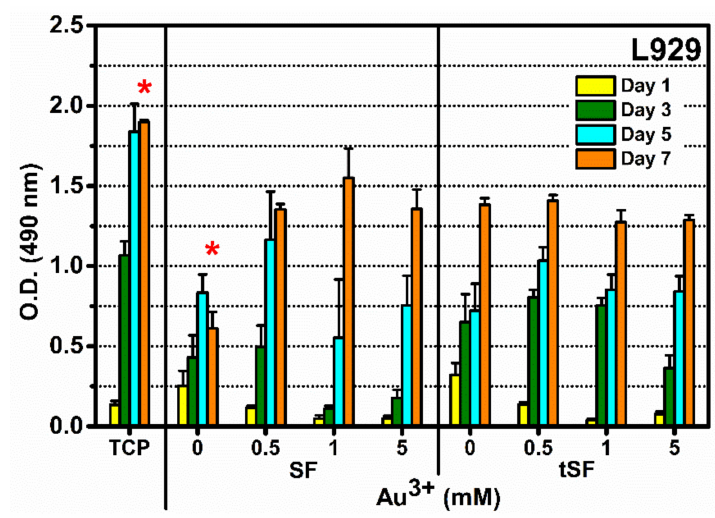
Figure 7. Cytocompatibility of SF and tSF hydrogels, and Au-SF and Au-tSF hydrogels with L929 rate fibroblasts. Cells were seeded on the hydrogels at 10,000 cells / cm 2 and cultured for 7 days. Cell metabolic activity was assessed by MTS assay ( n = 4) (TCP = tissue culture plate). * indicates statistical di ff erences at p ≤